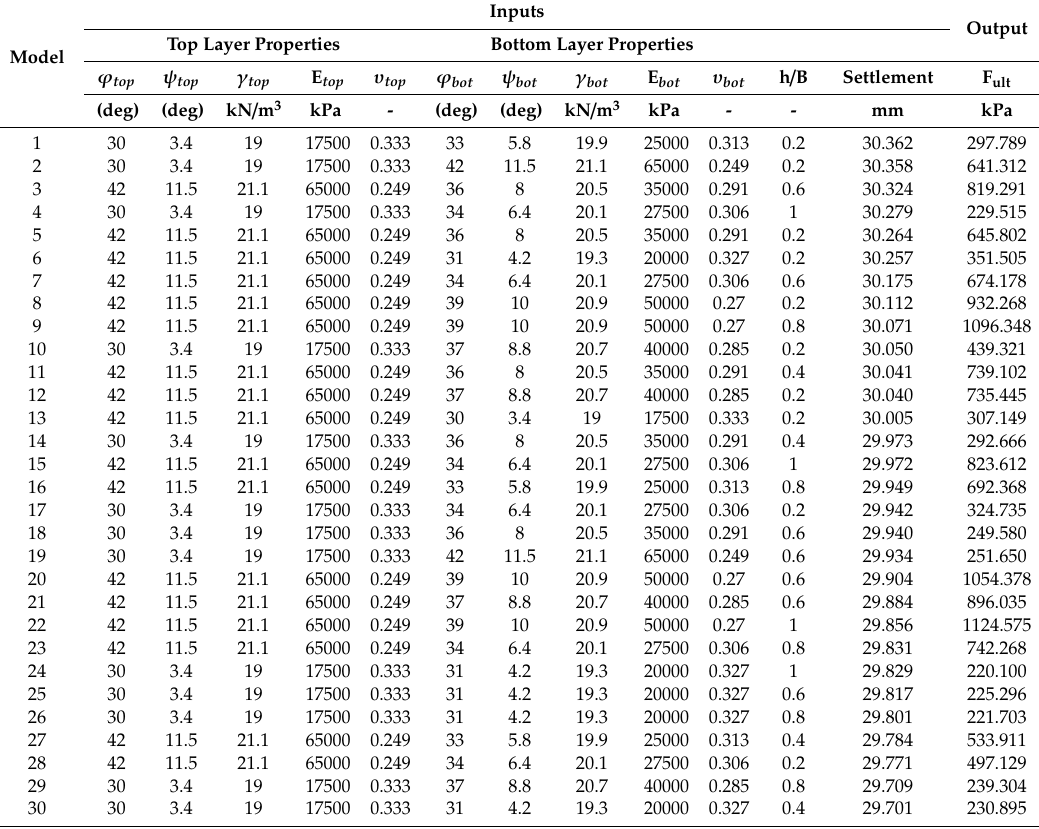
Table 2. Instance of input and also output datasets employed for simulating purpose in the estimation of F